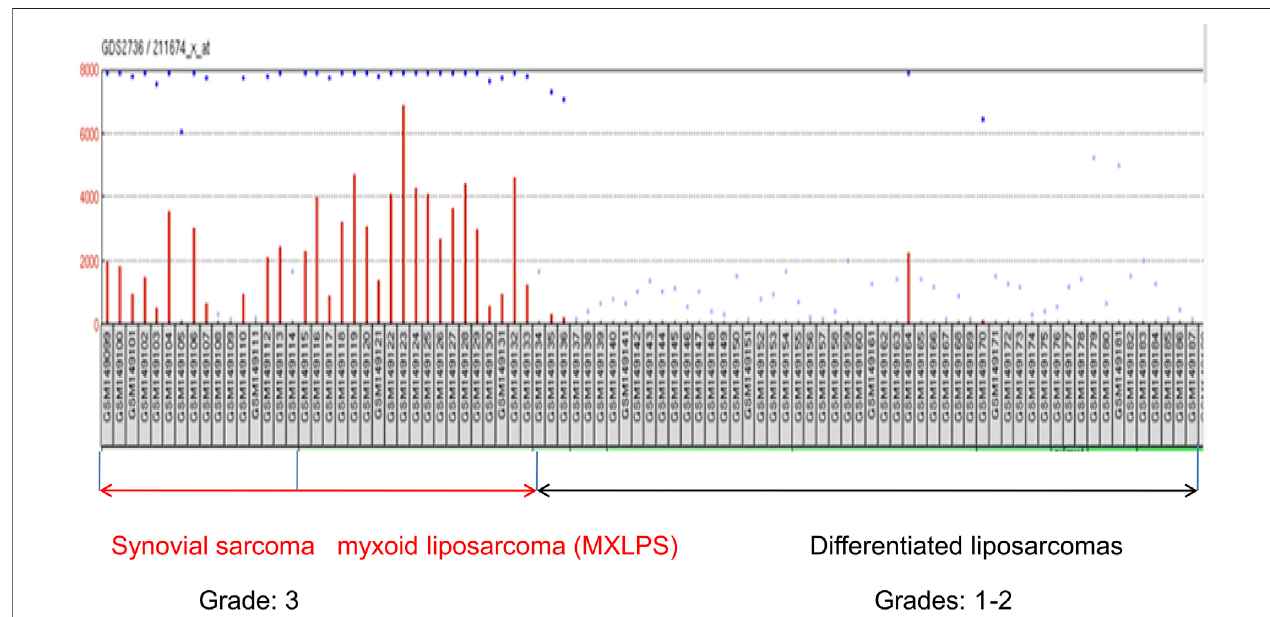
FIGURE 1 | Expression of ctag1b/a mRNA in different sarcoma samples retrieved from the GDS2736 archive. Notice that with the exception of two samples, various differentiated sarcomas of grades 1 – 2 uniformly lack expression of ctag1b/a . In contrast, ctg1b/a is re-expressed in most (grade 3) synovial and myxoid liposarcomas samples aswell as dedifferenatiatedliposarcomas. Expression unitson the Y axis are arbitrary transcriptomics units. Retrieved samples are designated by GSM, followed by a